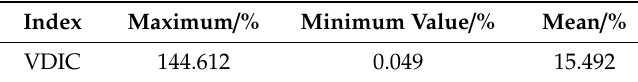
Figure 15. Node 21 charging VAP. Table 7. Node 21 VDIC indicator.